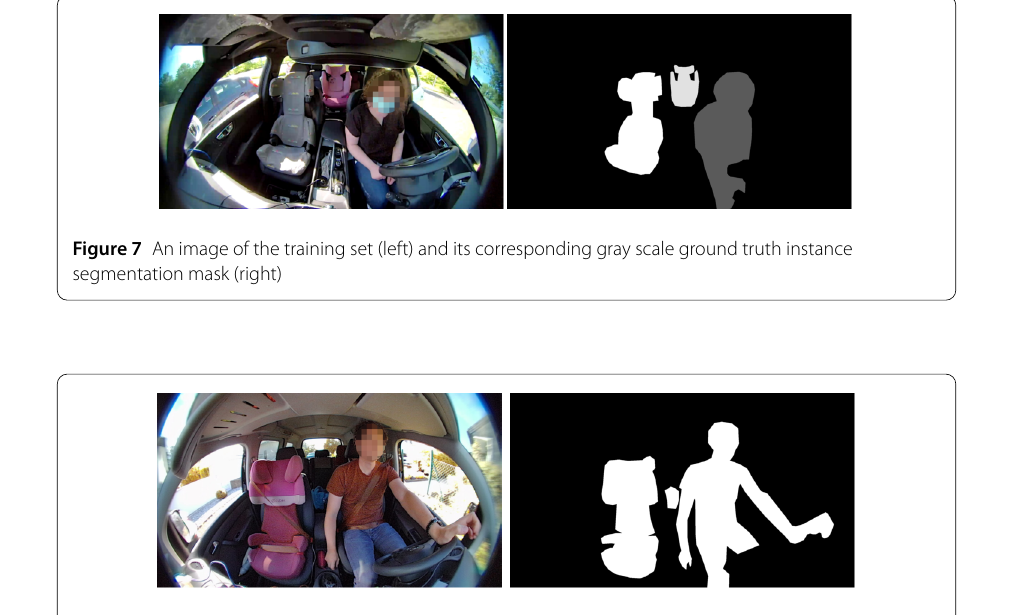
Figure 8 An image of the test set (left) and its corresponding binary ground truth segmentation mask